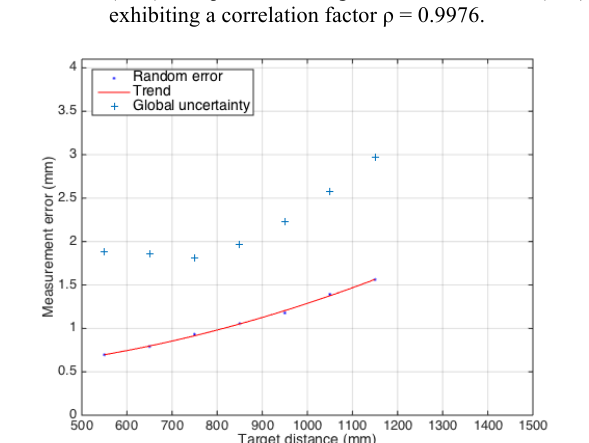
Figure 7. ASUS Xtion global uncertainty, random error and quadratic fitting on the random error ( ρ =0.9989).